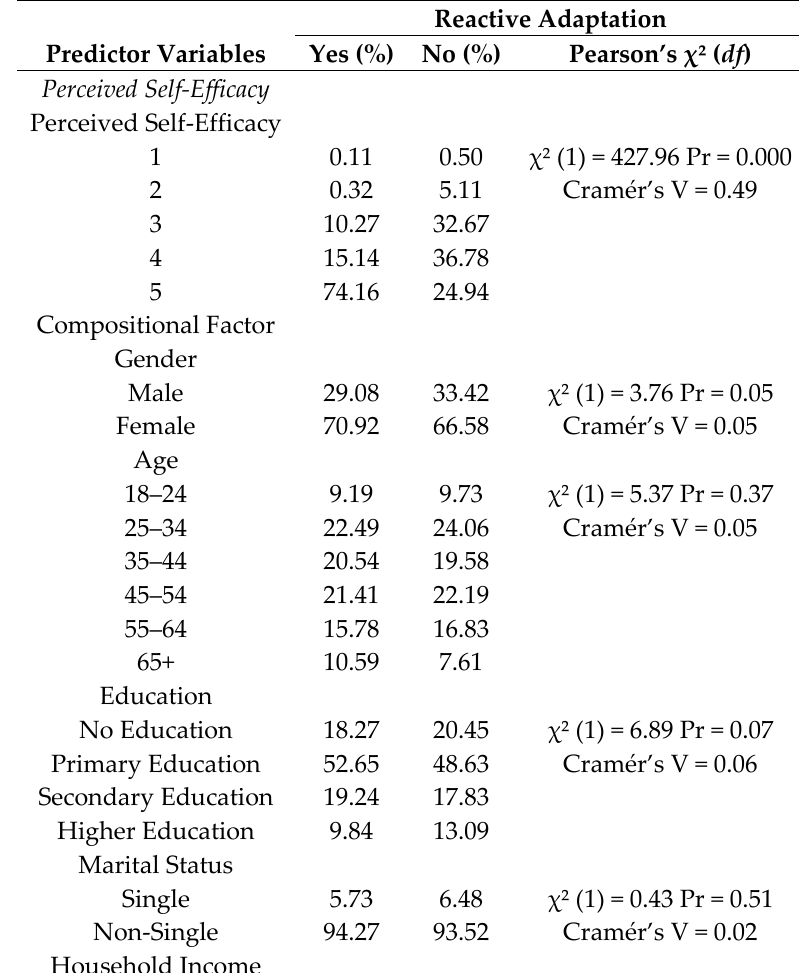
Table 2. Descriptive Statistics of Reactive Adaptation to Climate Change in Coastal Cambodia ( n =